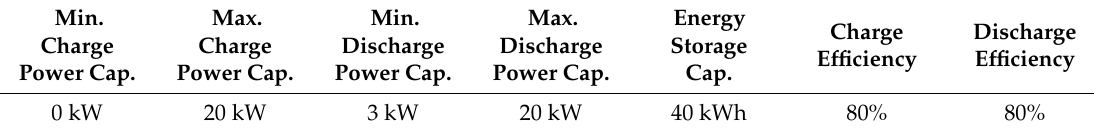
Table 11. The basic rules set by the manager.